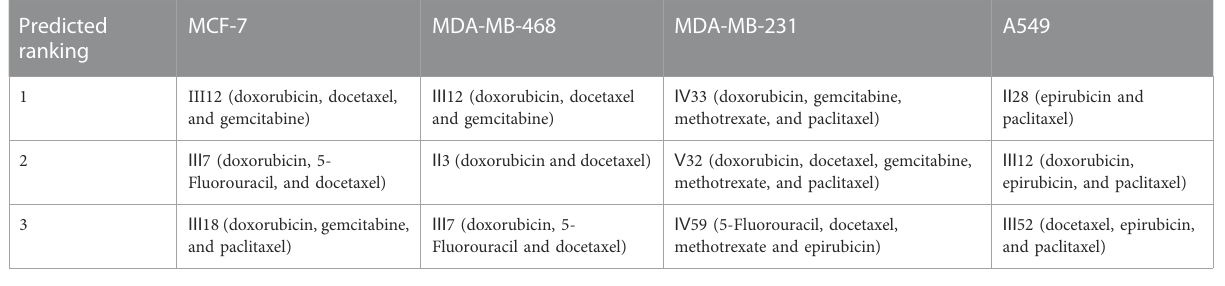
TABLE 4 The top three predicted combinations for a variety of cancer cell lines. Predicted ranking